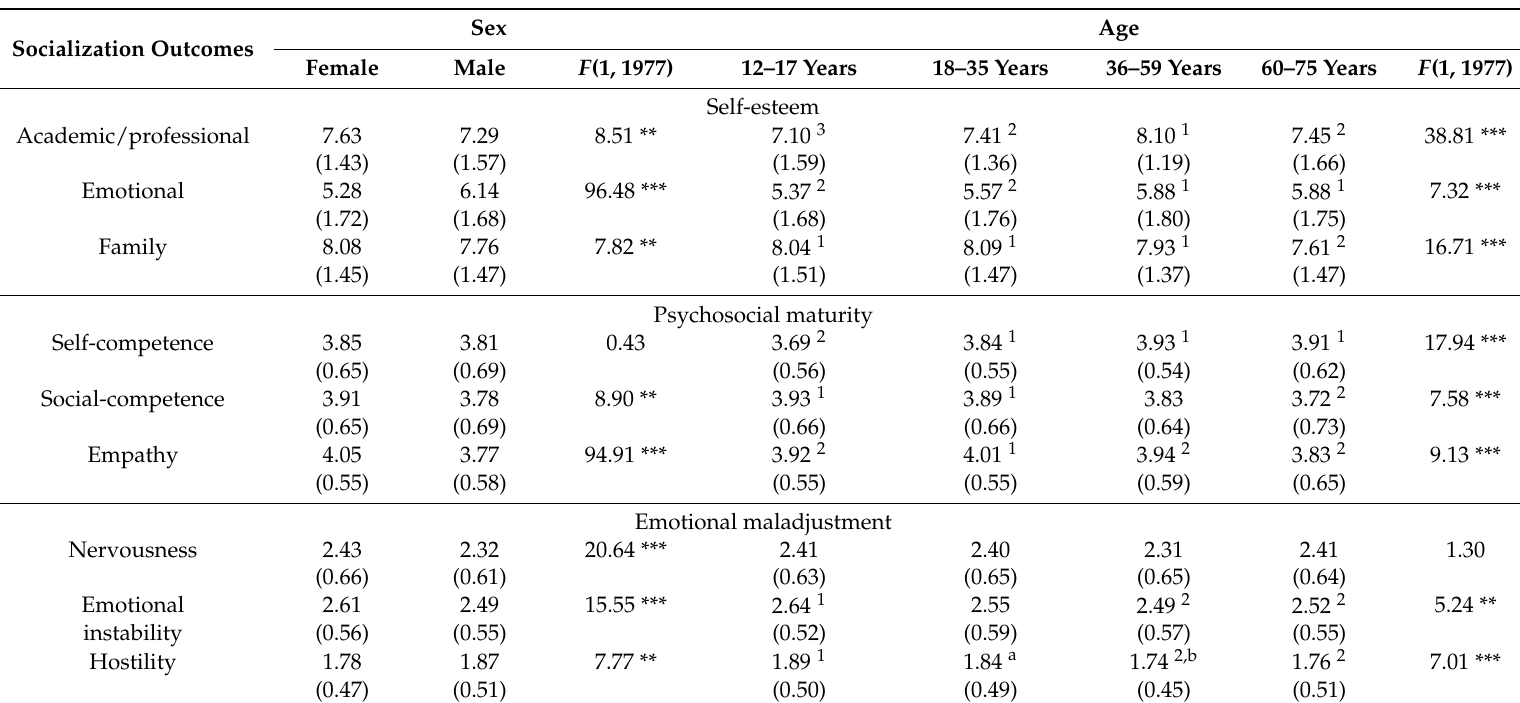
Table 4. Means (and standard deviations) for parenting style and school performance, and main univariate F values for the set of outcome measures (self-esteem, psychosocial maturity, and emotional